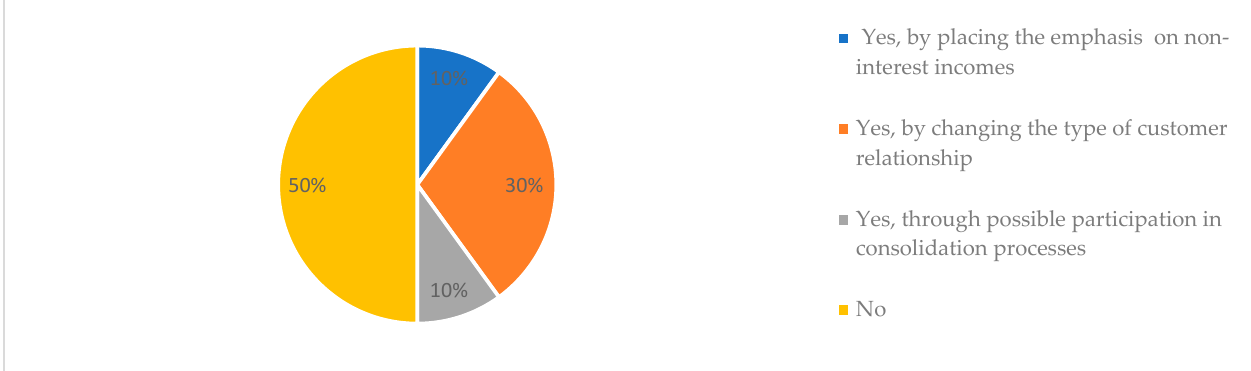
Figure 10. Has the COVID-19 pandemic revealed the need for a fundamental change in your bank strategy?